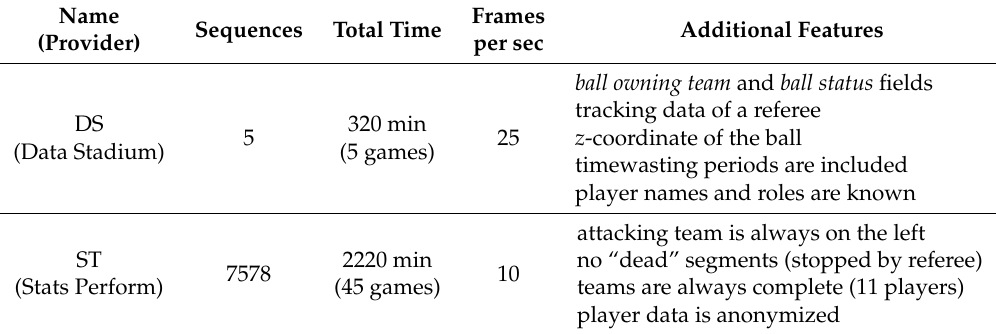
Table 1. Experimental